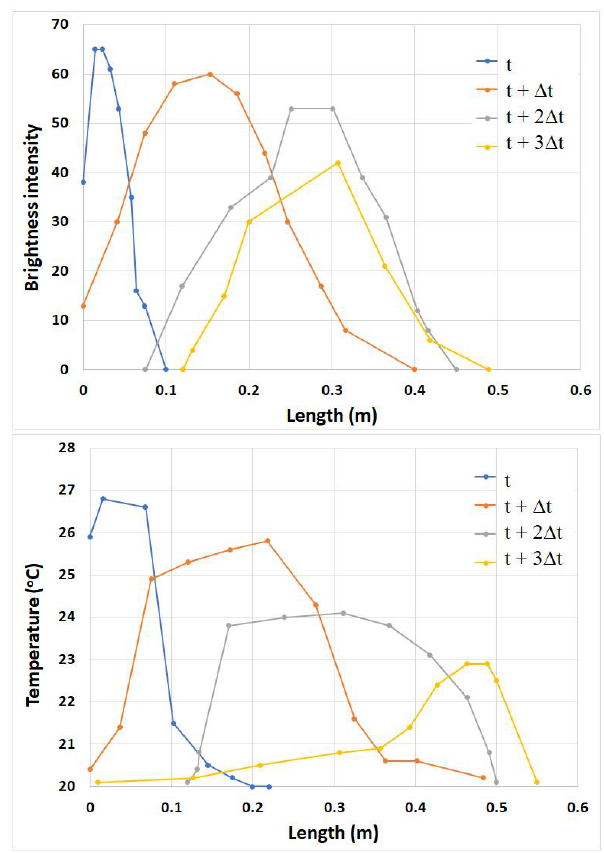
Figure 8. Brightness of the fluorescent quinine tracer ( top ) and temperature of the thermal tracer ( bottom ) over time (t, t + Δt, t + 2Δt, t + 3Δt), along the flume’s length (scanned area). Comparison between the two graphs shows that the decay of temperature in the thermogram is stronger than the reduction of brightness intensity in the quinine tracer. These examples are from tracer movements over the plane surface (Q = 113.63 mL/s, V tr = 7.5